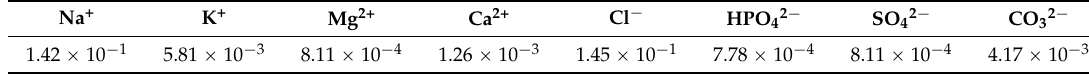
Table 1. Composition of Hanks’ solution used in this study (mol ¨ L ´ 1